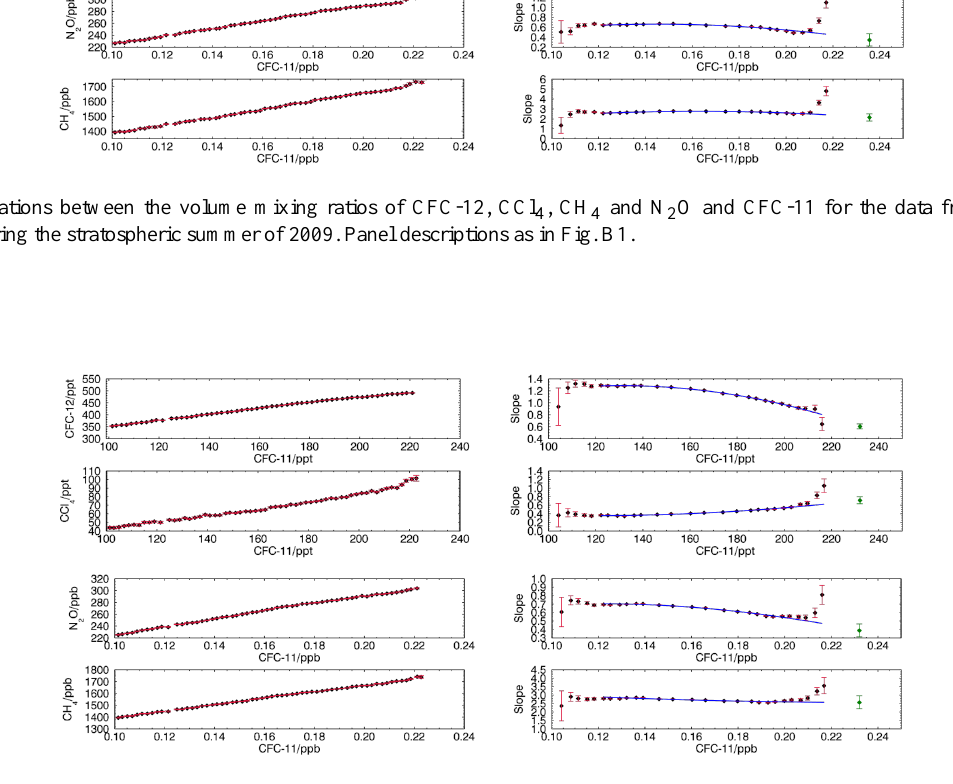
Figure B5 Correlations between the volume mixing ratios of CFC-12, CCl 4 , CH 4 and N 2 O and CFC-11 for the data from the northern hemisphere during the stratospheric summer of 2010. Left panels: The mean correlation profile. Each point represents the mean of the VMR in a window of 2 ppt of CFC-11. The error on these points is the standard deviation of the data within each 2 ppt window. Right panels: The local slope of data in an 80 ppt of CFC-11 window. The error on the points is the fitting error of this fit. The blue line is a second degree polynomial fit to the local slopes. The green point is the extrapolated slope at the tropopause.